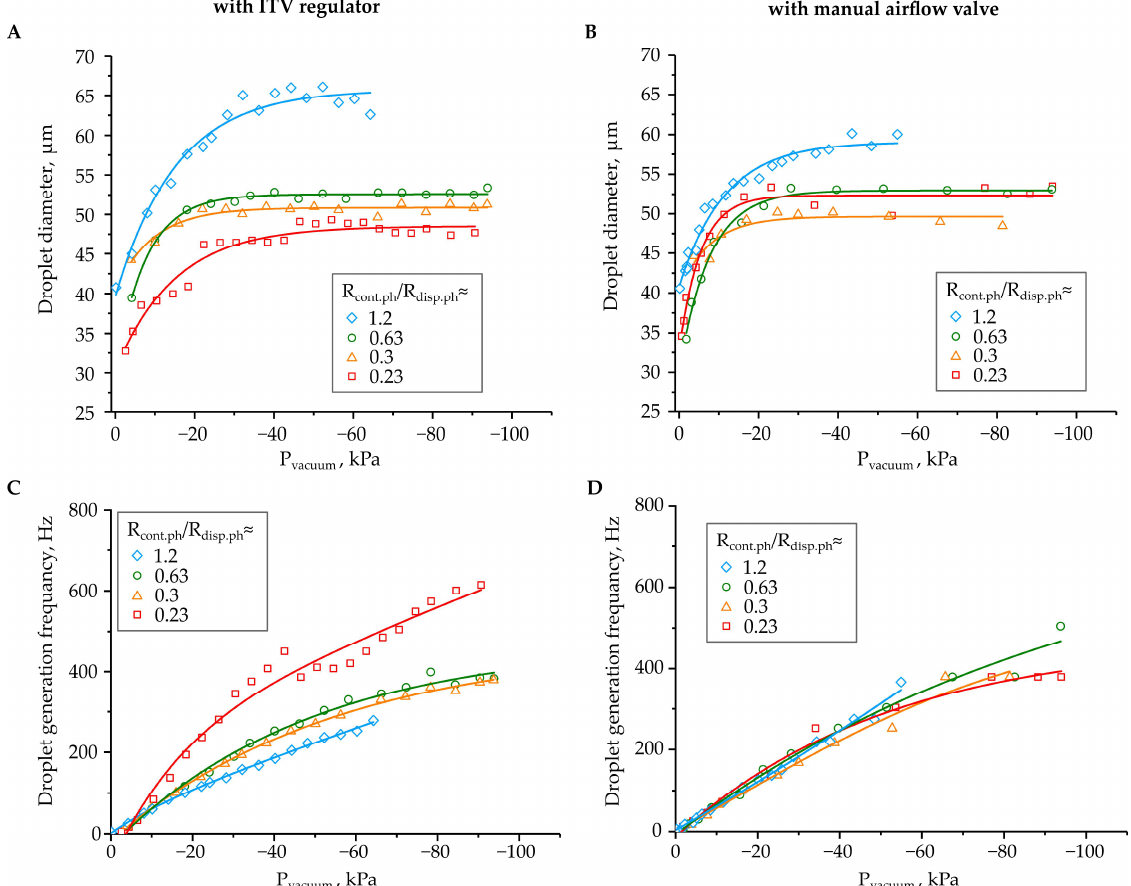
Figure 3. Characteristics of the droplet generation regimes in the flow-focusing microfluidic device at different negative pressures in the outlet reservoir, and different hydrodynamic resistances of inlet channels in the setup with the ITV pressure regulator or with the manual airflow control valve: ( A , B ) diameters of obtained droplets; ( C , D ) droplet generation frequencies. Colored lines are eye guides.